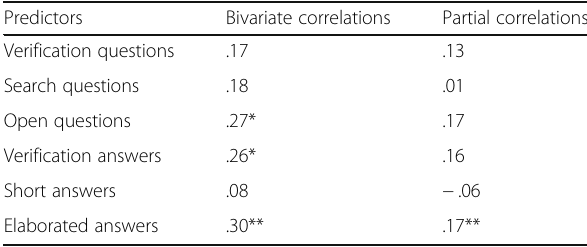
Table 3 The bivariate and partial correlation coefficients of the question episode categories with students ’ individual